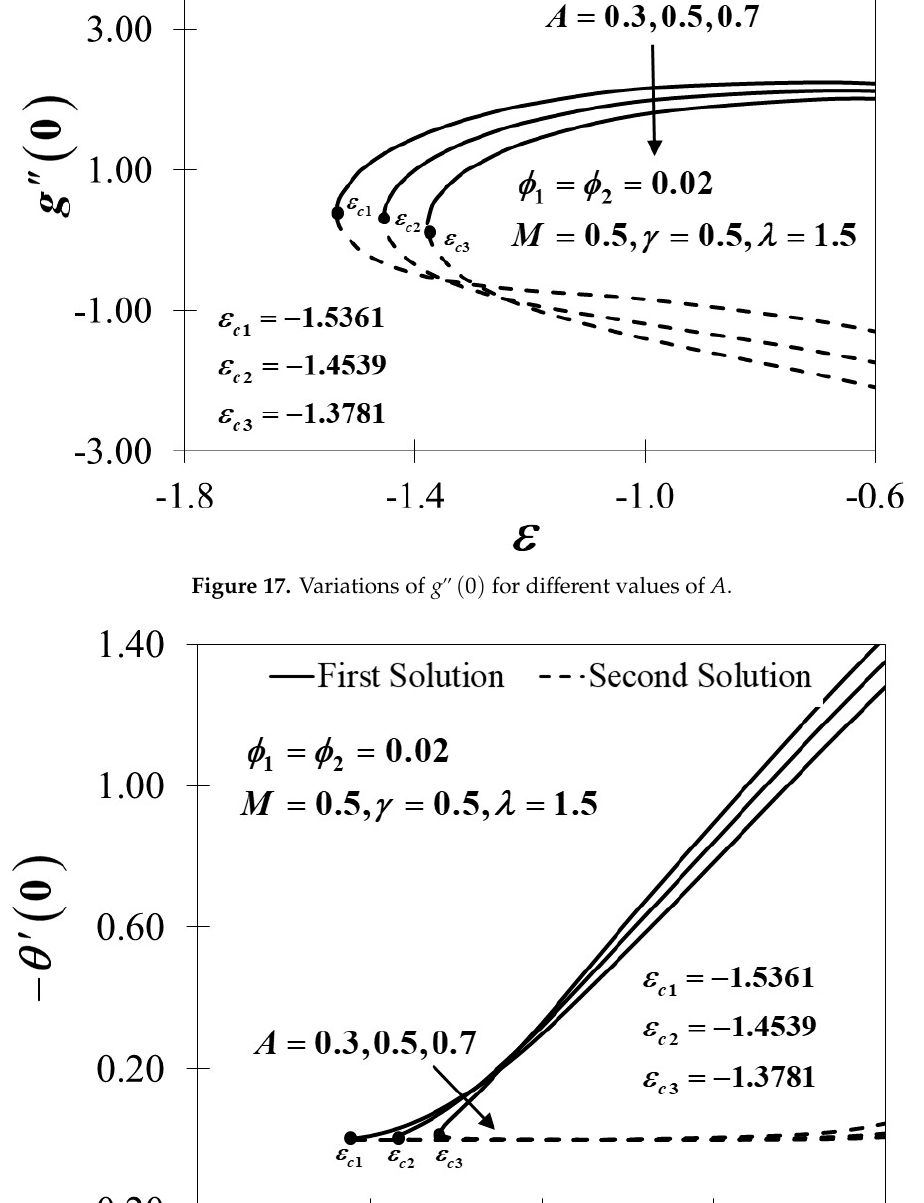
Figure 18. Variations of − θ′(0) for different values of A .